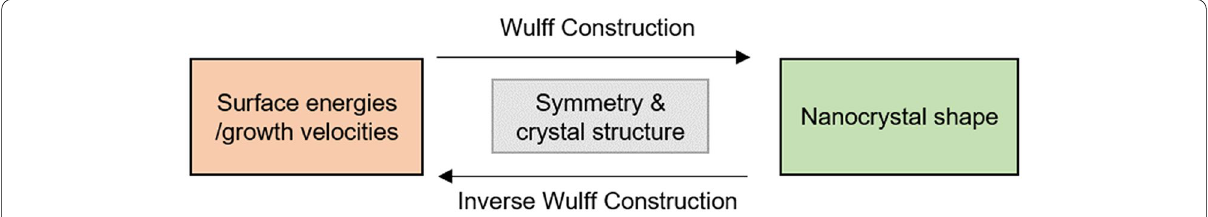
Fig. 7 Flow chart illustrating the forward and inverse Wulff construction